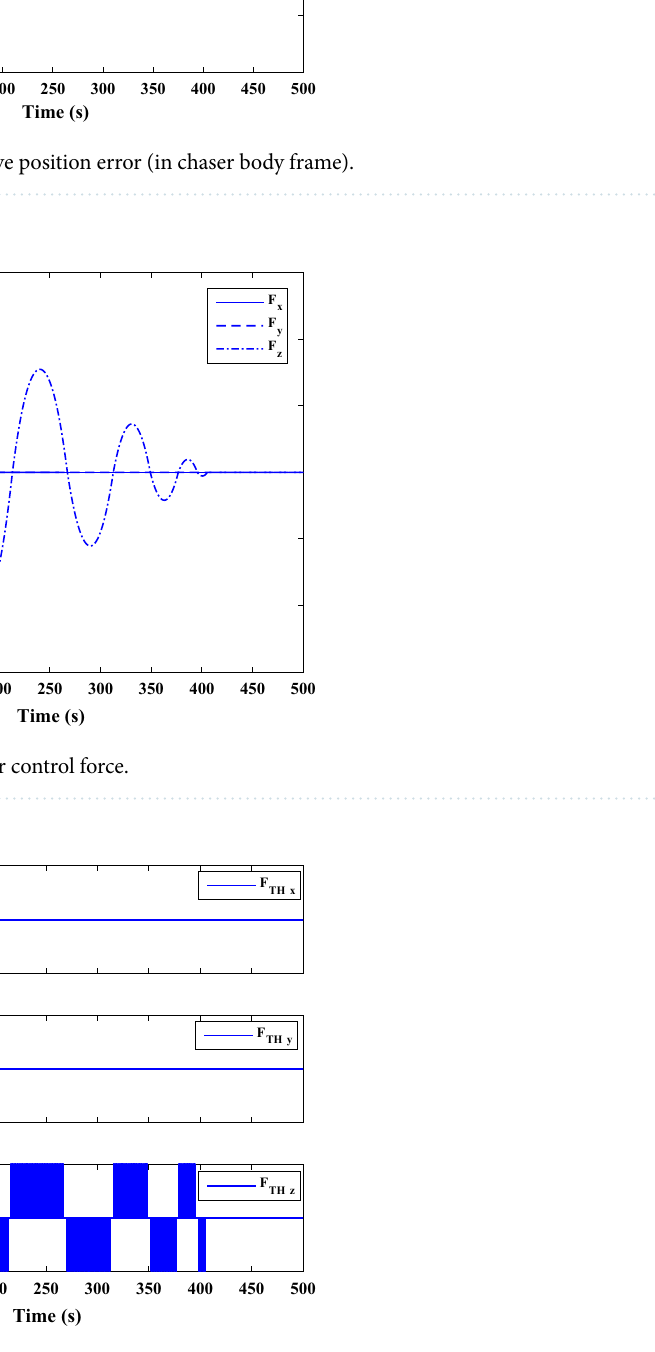
Figure 48. Scenario II: chaser’s thrusters